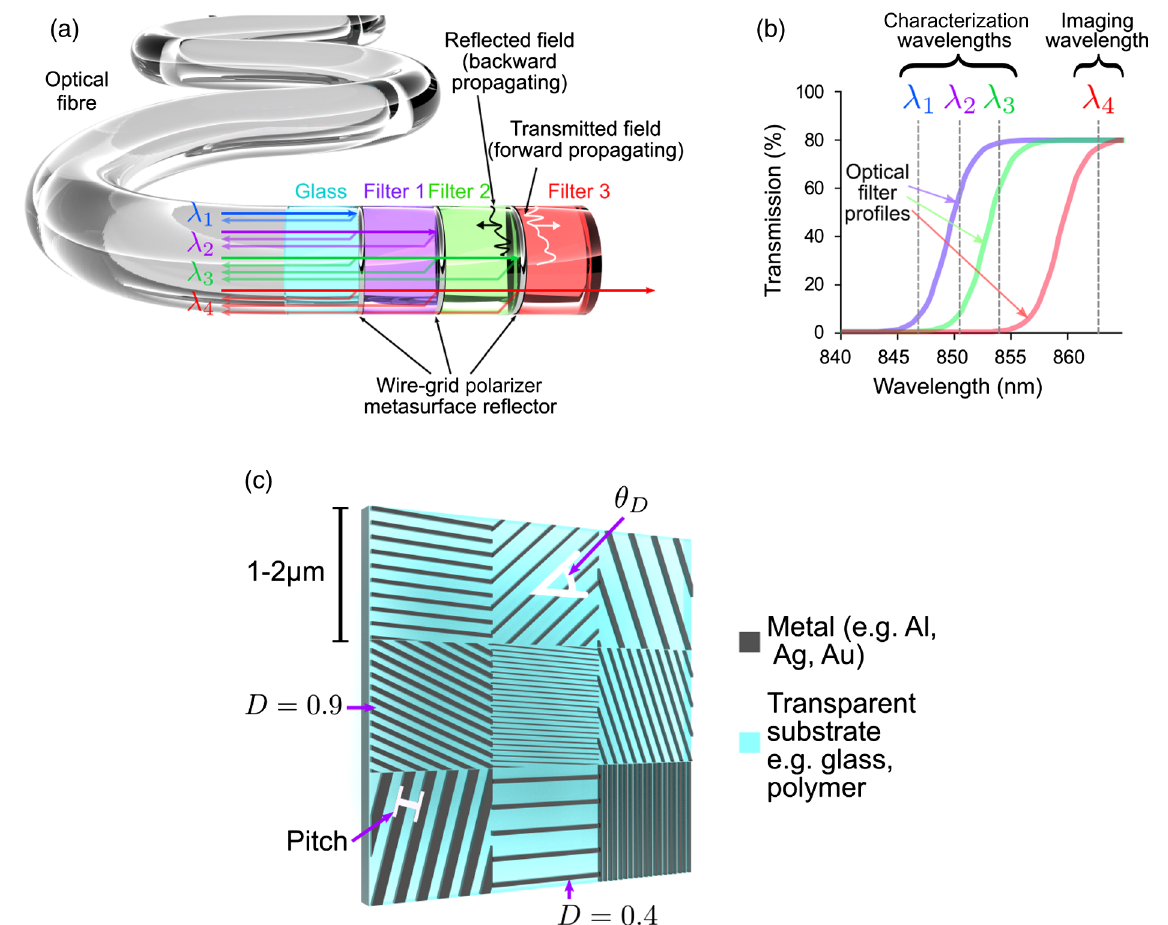
FIG. 3. Design of a wavelength-dependent reflector stack: (a) Proposed stack structure, attached to the distal facet of an optical fiber, comprising layers of glass and long-pass optical filters with wire-grid polarizer metasurfaces sandwiched between. Light paths are shown for the four different wavelengths used: the characterization wavelengths λ 1 , λ 2 , and λ 3 , each producing three PMs, R λ ¼ λ … ; λ λ λ ; 1 ; 3 ; and the imaging wavelength 4 that passes through the stack. Optical fields exiting the fiber propagate through each layer via diffraction and are partially reflected at the metasurfaces generating backward propagating wavefronts. The sum of all backward propagating components represents the field coupled back into the fiber. (b) Spectral transmission profiles of the three long- pass optical filters with example imaging and characterization wavelengths labeled. (c) Example design of wire-grid polarizer metasurface comprising an array of diattenuating cells of size 1 – 2 μ m containing nanowire gratings with varying pitch (50 – 200 nm), duty cycle (25% – 75%), and orientation ( 0 − 2 π ). The pitch and duty cycle determine the linear diattenuation of each cell, D , and the orientation determines the diattenuation axis θ . These are used to form a Jones matrix for each cell that determines its optical D transmission and